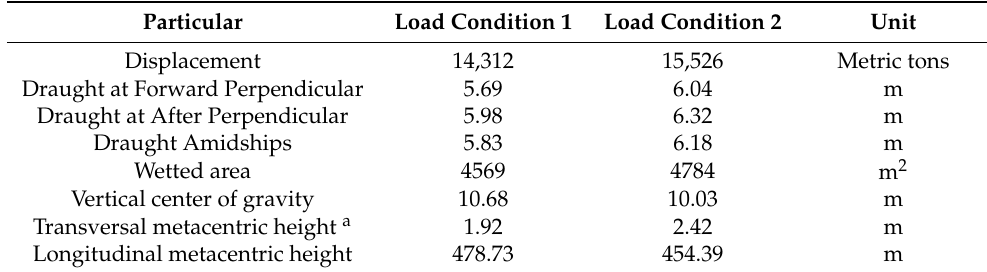
Table 2. Load conditions used for total resistance calculation. Particular